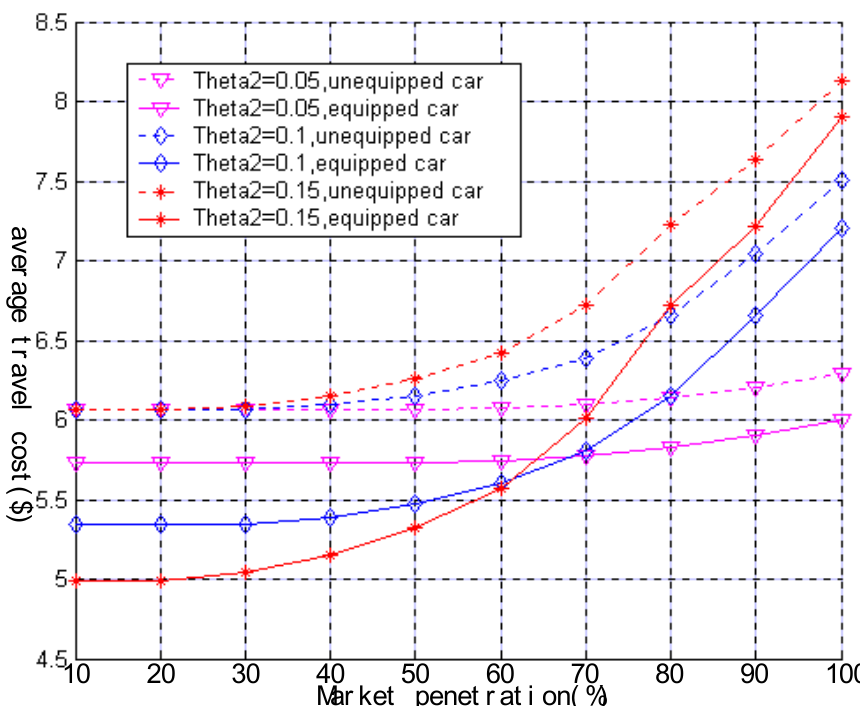
Figure 10. Average travel cost of car with respect to market penetration